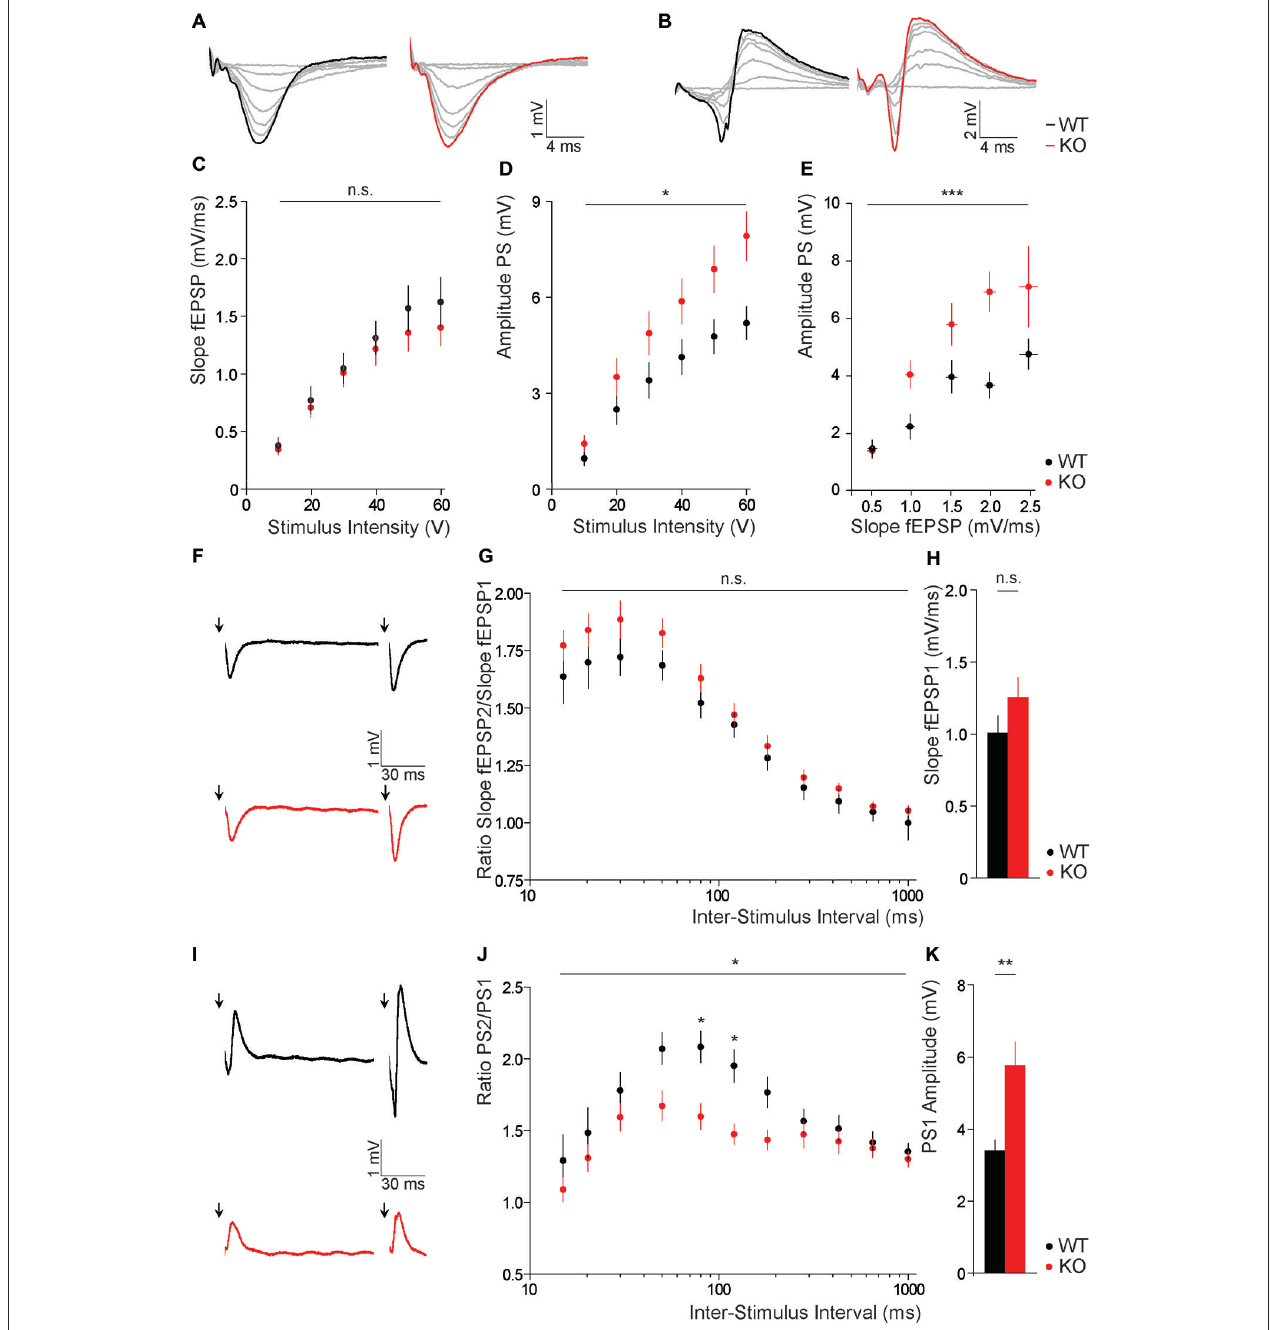
in the stratum radiatum (F) upon repeated stimulation of Schaffer collaterals with an inter-stimulus interval of 120 ms in WT and KO slices. (G) Disruption of Slc4a10 had no impact on dendritic paired-pulse facilitation ( p > 0.05; n = 18/17). (H) Mean fEPSP slopes upon stimulation with half-maximal stimulus intensity did not differ between genotypes ( p > 0.05; n = 18/17). (I) Exemplary responses of fEPSP recorded in the stratum pyramidale upon repeated stimulation of Schaffer collaterals with an inter-stimulus interval of 120 ms in WT and KO slices. (J) Paired-pulse facilitation at an inter-stimulus interval of 80 and 120 ms was decreased ( p = 0.04; n = 18/22). (K) Note, at half-maximal stimulus intensity the mean first PS amplitude also showed a significant increase in KO slices. ( p = 0.001; n = 18/22). * p < 0.05 ** p < 0.005 *** p <